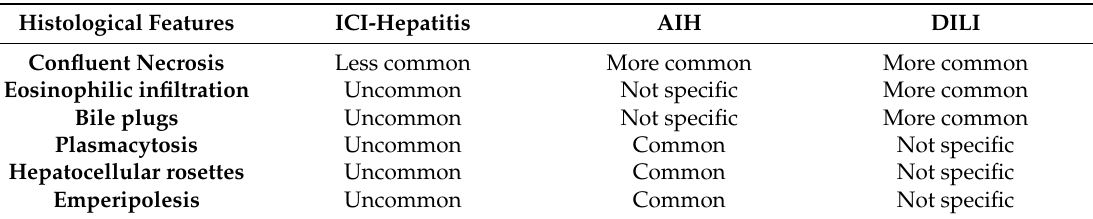
Table 1. Comparison of histopathological features of ICI-induced hepatitis, autoimmune hepatitis (AIH) and drug-induced liver injury (DILI). Adapted from Zen et al [2]. Histological Features ICI-Hepatitis AIH DILI Confluent Necrosis Less common More common More common Eosinophilic infiltration Uncommon Not specific More common Bile plugs Uncommon Not specific More common Plasmacytosis Uncommon Common Not specific Hepatocellular rosettes Uncommon Common Not specific Emperipolesis Uncommon Common Not